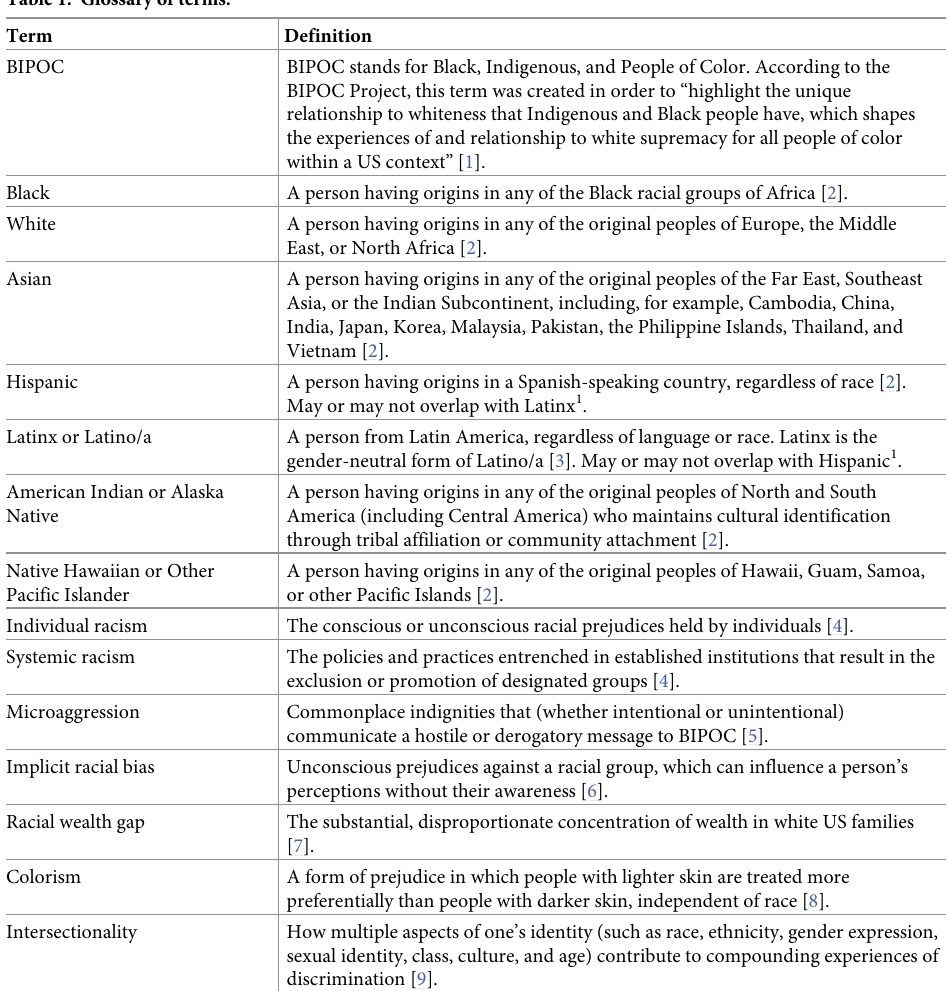
Table 1. Glossary of